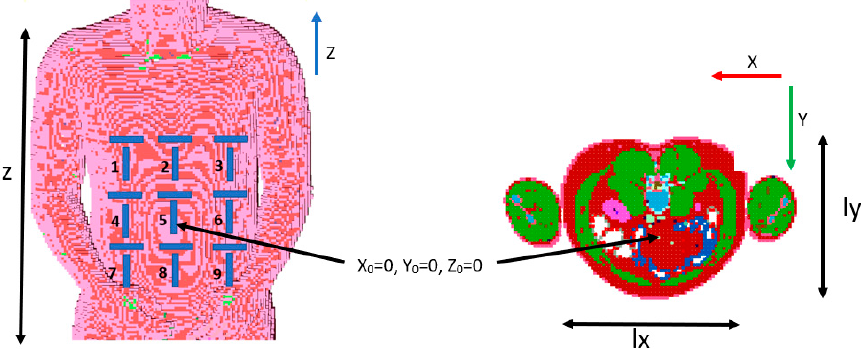
Figure 16. Dimensions of used human body model: lx = 330 mm, ly = 290 mm, lz = 650 mm, and adopted coordination system.